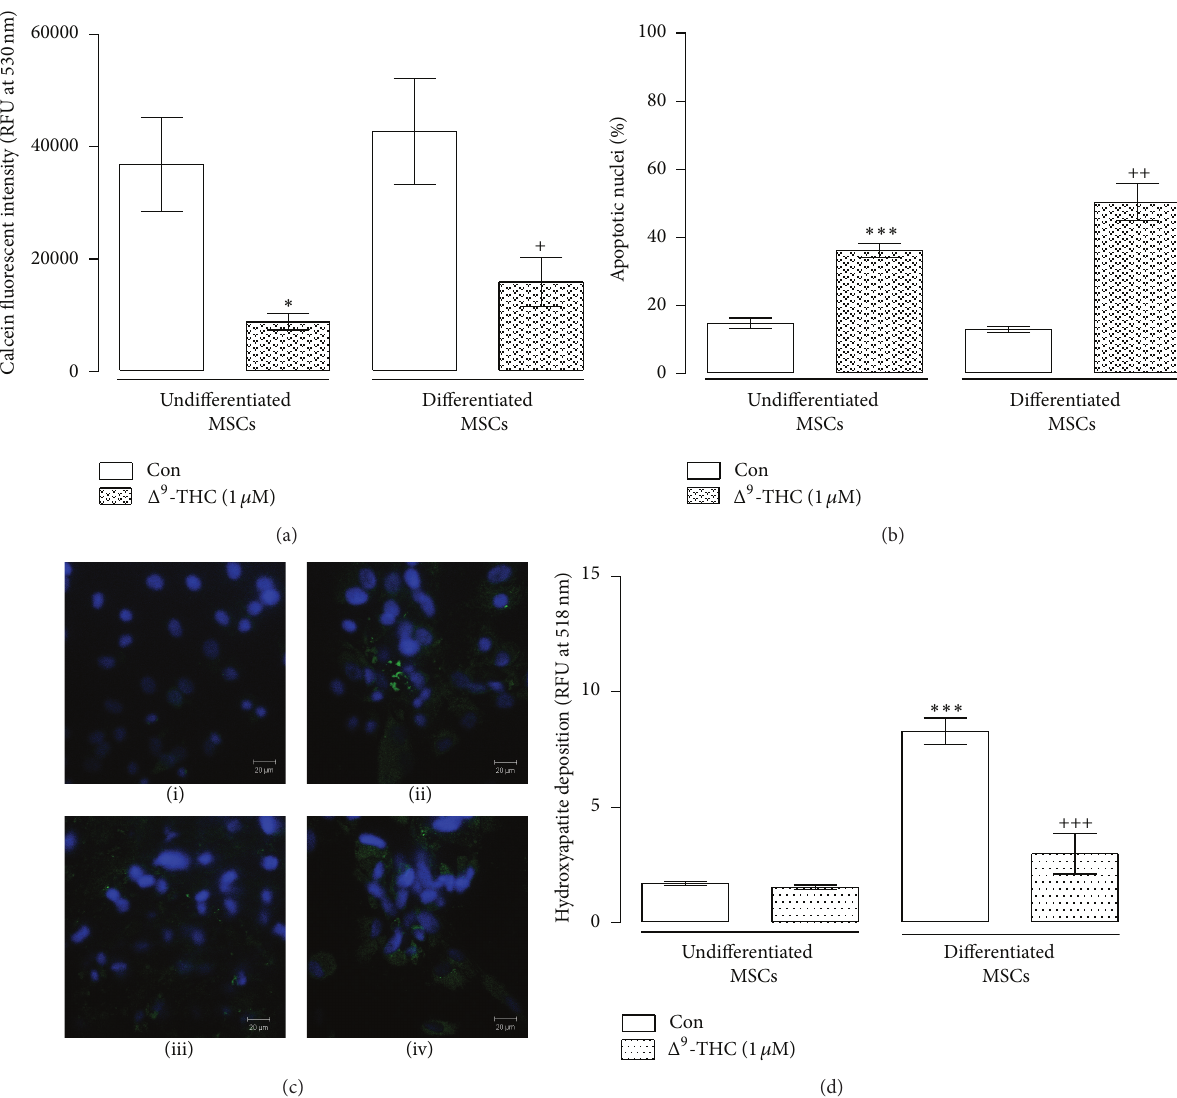
Figure 2: Δ 9 -THC negatively affects MSC viability and inhibits MSC osteogenesis. (a) Treatment of undifferentiated MSCs with Δ 9 -THC (1 𝜇 M) significantly reduced viability compared to control undifferentiated MSCs (Con; ∗ 𝑃 < 0.05 , 1-way ANOVA and Newman-Keuls, 𝑛 = 5 ). Also, differentiation of MSCs in the presence of Δ 9 -THC significantly decreased viability compared to control differentiated MSCs (Con; + 𝑃 < 0.05 , 1-way ANOVA and Newman-Keuls, 𝑛 = 5 ). (b) Treatment of undifferentiated MSCs with Δ 9 -THC induced a significant increase in the percentage of apoptotic nuclei compared to control MSCs (Con; ∗∗∗ 𝑃 < 0.001 , 1-way ANOVA and Newman-Keuls, 𝑛 = 6 ). Also, differentiation of MSCs in the presence of Δ 9 -THC significantly increased the percentage of apoptotic nuclei compared to control differentiated MSCs ( ++ 𝑃 < 0.001 , 1-way ANOVA and Newman-Keuls, 𝑛 = 6 ). (c) Representative images of cells stained for active caspase-3 in control undifferentiated MSCs (i), undifferentiated MSCs treated with Δ 9 -THC (ii), control differentiated MSCs (iii), and differentiated MSCs in the presence of Δ 9 -THC (iv). (d) Differentiation of MSCs in the presence of Δ 9 -THC (1 𝜇 M) significantly decreased hydroxyapatite deposits compared to control differentiated MSCs ( +++ 𝑃 < 0.001 , 1-way ANOVA and Newman-Keuls, 𝑛 = 6